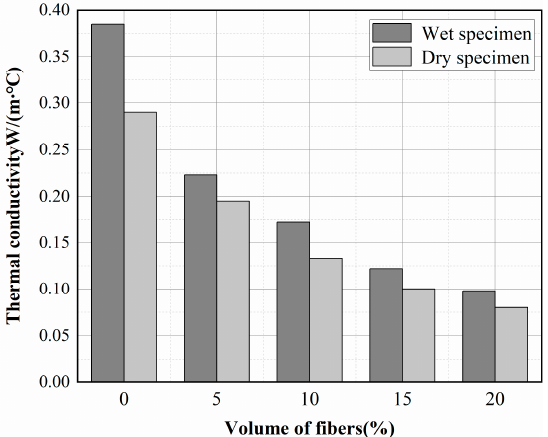
Figure 11. Effect of fiber content on the thermal conductivity of insulating concrete.